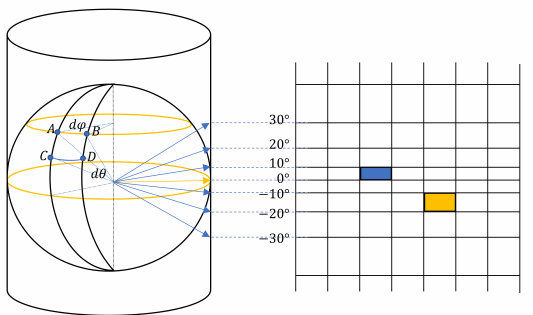
Figure A1. SLDEM is a simple cylinder projection. The actual areas depicted by grids of various latitudes and longitudes based on SLDEM data are